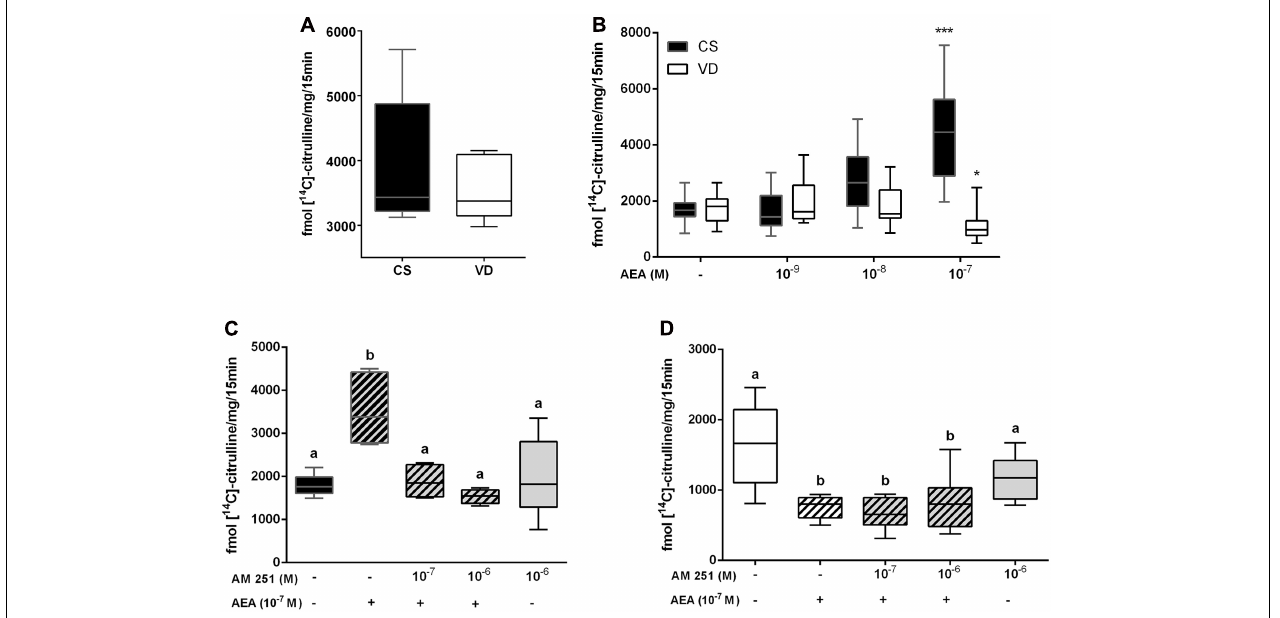
FIGURE 2 | Characterization of nitric oxide synthase (NOS) activity in term placenta. (A) Basal NOS activity measured in CS and VD placentas ( n = 8). (B) NOS activity measured after culturing CS and VD placentas with different concentrations of AEA (*** P < 0.001, * P < 0.05 vs. control, n = 8). (C) NOS activity measured after culturing CS placentas and (D) VD placentas with 10 - 7 M AEA and different concentrations of AM 251. Different letters represent significant changes ( P < 0.05 vs. control, n = 8) and the plain gray bar shows that AM 251 has no effect per se